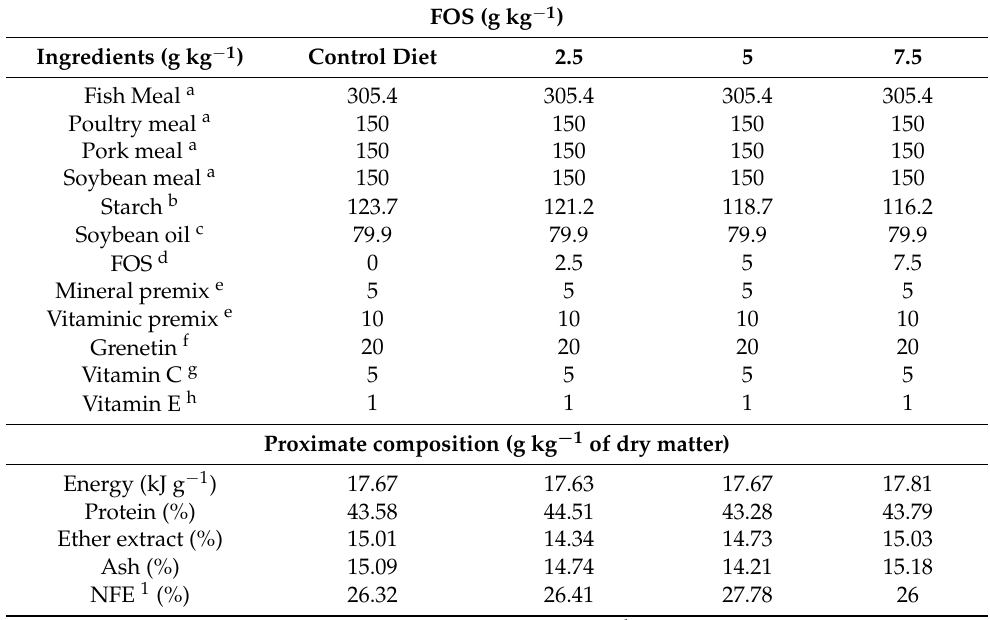
Table 1. Composition of experimental diets with different concentrations of